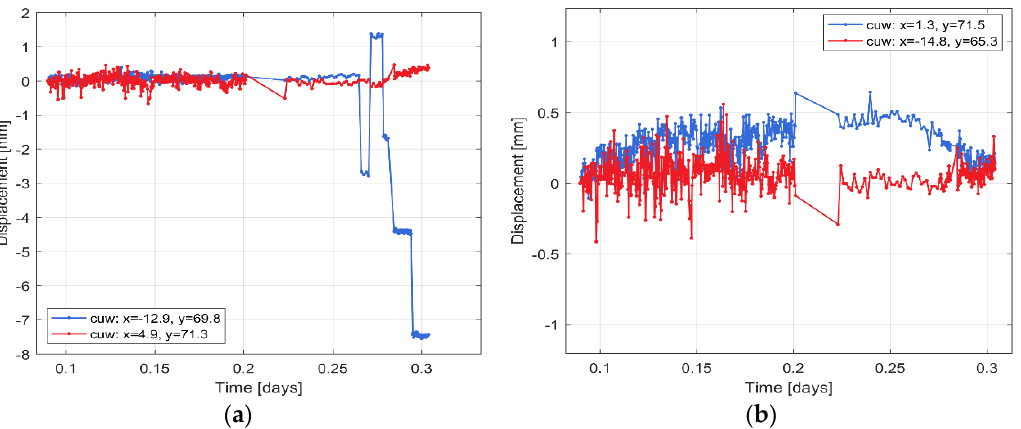
Figure 14. Displacement of sight line after atmospheric correction of the four representative PSs. ( a ) indicates points ( − 12.9, 69.8) and (4.9, 71.3); ( b ) indicates the point (1.3, 71.5) with ( − 14.8, 65.3).